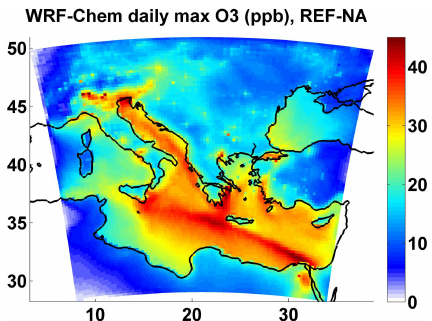
Fig. 15. Change in daily maximum near-surface ozone (ppbv) due to anthropogenic emissions (REF-NA) calculated by WRF-Chem and averaged over the summer (JJA)